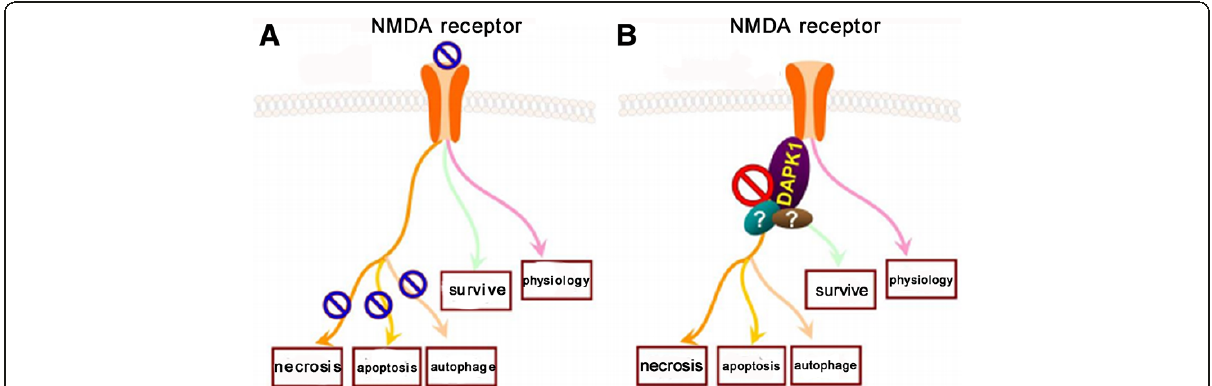
Figure 2 Blockade of NMDA receptor or NMDA-DAPK1 downstream signaling induces different fates of neuronal cells in stroke. (A) Blockade of NMDA receptor in stroke causes 1) inhibition of necrosis, apoptosis and autophagy of neuronal cells; 2) suppression of endogenous surviving and regeneration signaling; 3) interruption of physiological functions of synaptic transmission. (B) Blockade of NMDA(NR2B)-DAPK1 downstream signaling in stroke specifically mediates 1) prevention of cell death (such as necrosis, apoptosis and autophagy); 2) probable inhibition of cell survival; and 3) no adverse effects on physiological functions of synaptic